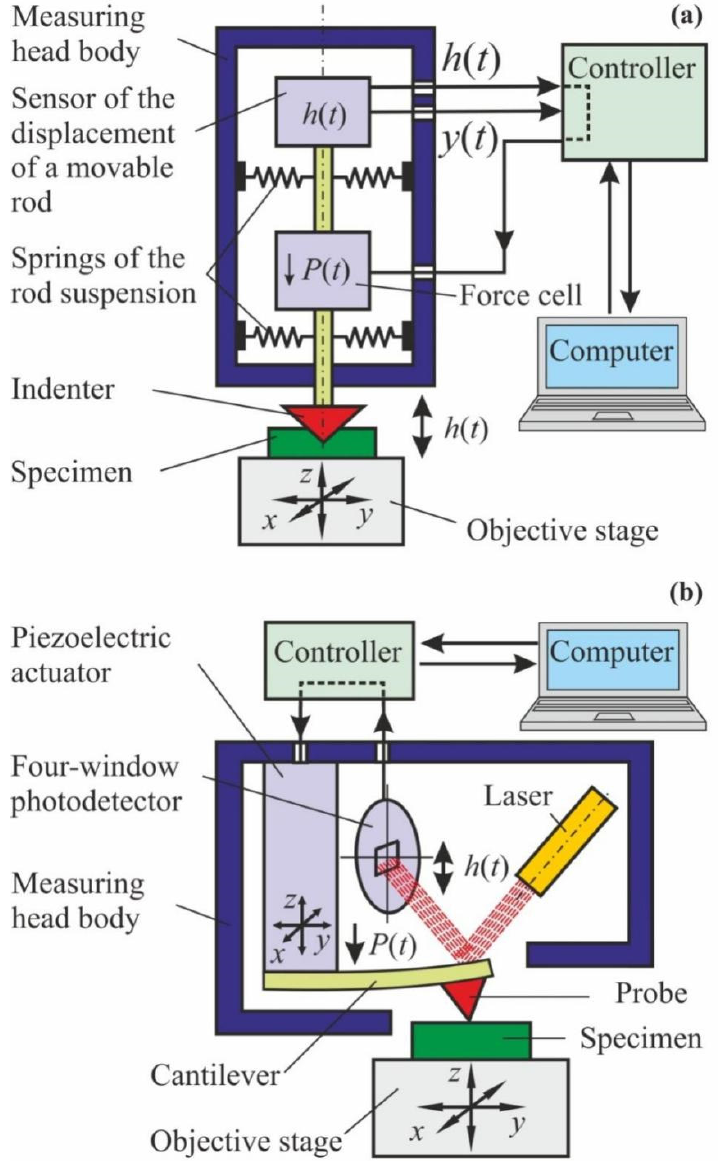
Figure 5. Schematic diagrams of ( a ) the nano-indentometer and ( b ) the atomic-force microscope.